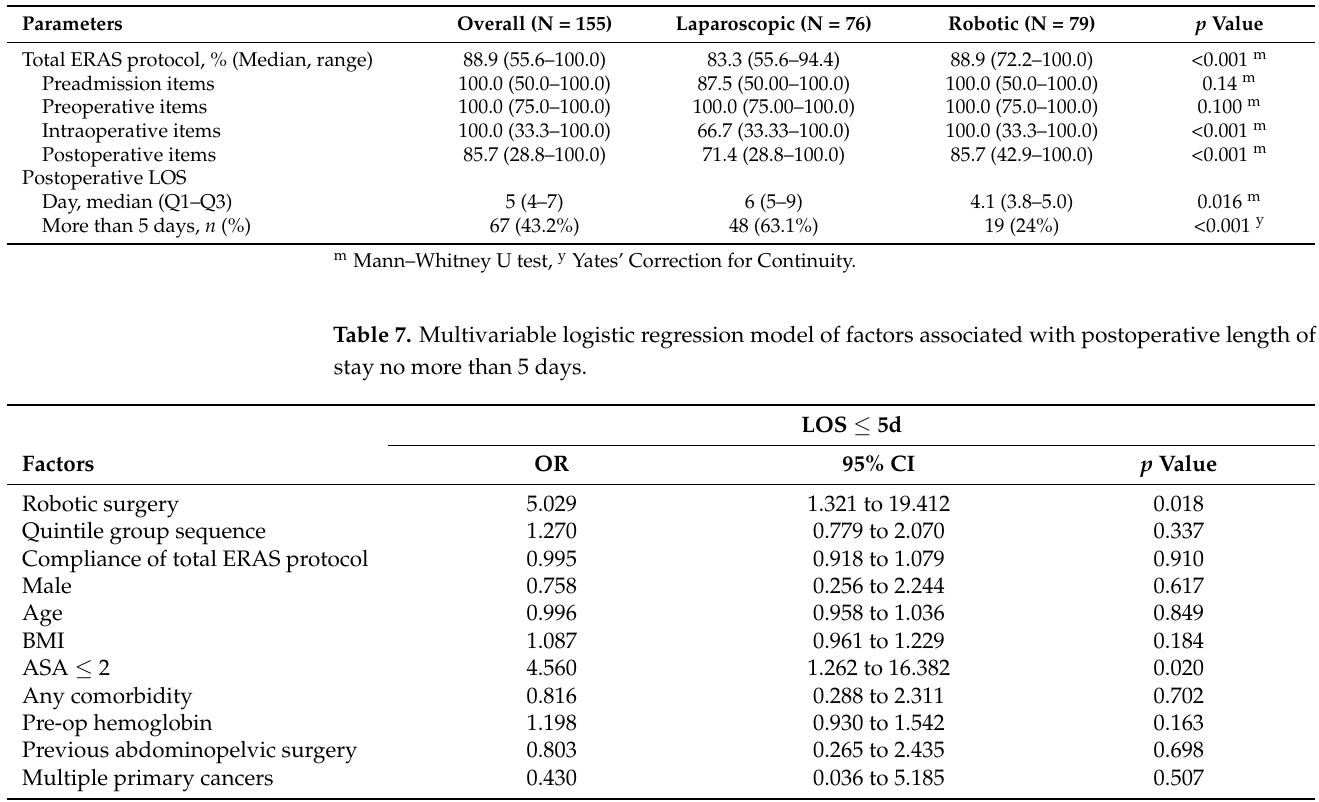
Figure 1. Cumulative numbers between Laparoscopic and Robotic group. Table 6. Comparison of ERAS compliance and LOS between laparoscopic and robotic surgery.